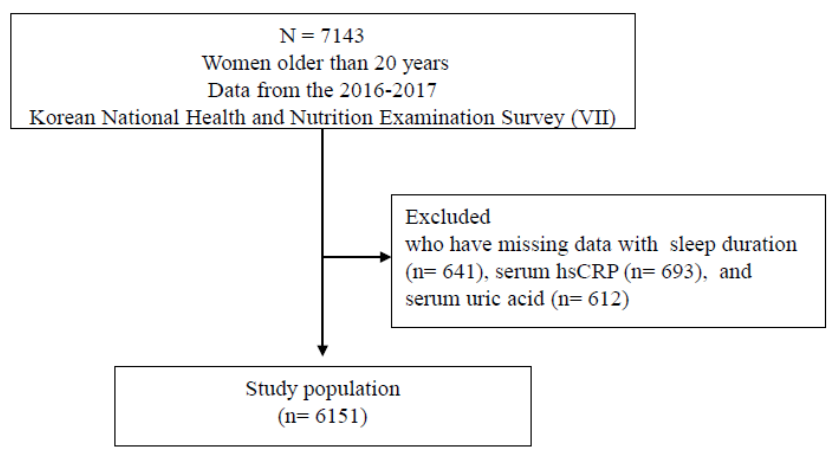
Figure 1. Study population selection process.